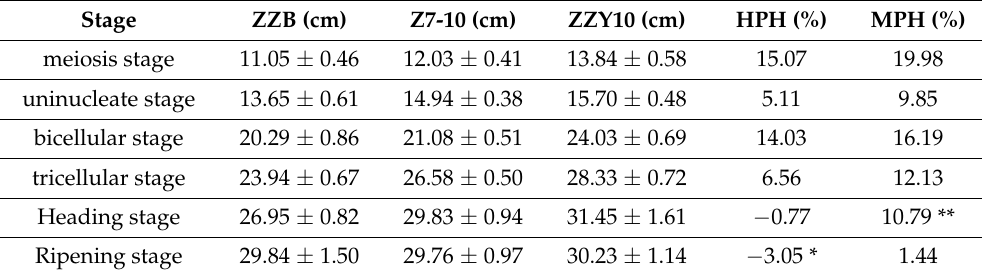
Table 2. MPH and HPH heterosis of panicle length during male